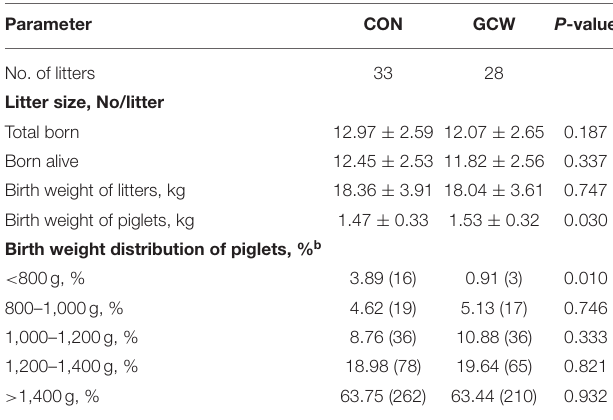
TABLE 1 | Effects of dietary supplementation with GCW during gestation on reproductive performance of sows a .